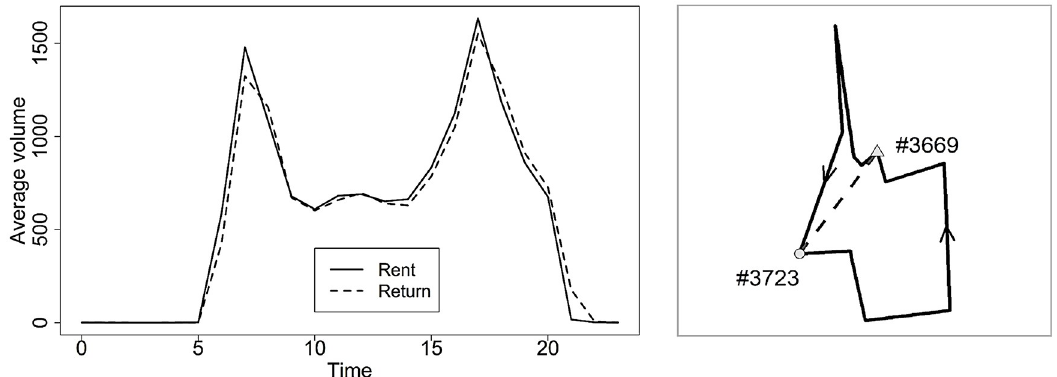
Fig 4. (a) Average volumes of the rent (return) per hour in Xiasha from August 9, 2013 to November 12, 2013; (b) The actual shortest driving paths in the opposite directions (solid) and the straight path (dashed) between the station #3669 and the station